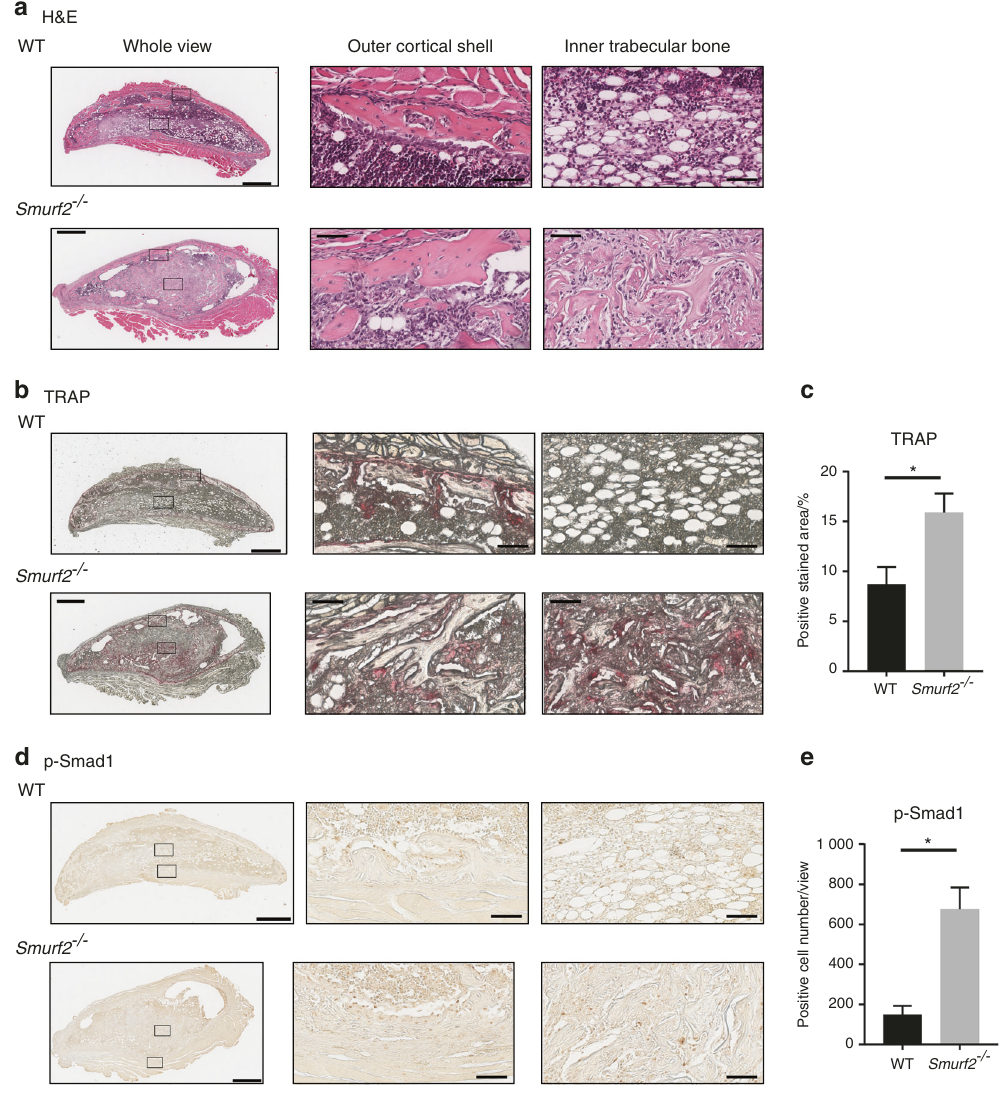
Fig. 4 Histology of rhBMP2-induced ectopic bone. a H&E staining of rhBMP2-induced ectopic bone. b TRAP staining of rhBMP2-induced ectopic bone. c TRAP-stained area ( n = 3; * P < 0.05 by Student ’ s t test). d Immunohistochemical staining of rhBMP2-induced ectopic bone with an anti-p-Smad1 antibody. e p-Smad1-positive cell numbers ( n = 3; * P < 0.05 by Student ’ s t test). (Whole view, scale bar = 600 μ m; outer Ct. bone and inner Tb. bone, scale bar = 60 μ